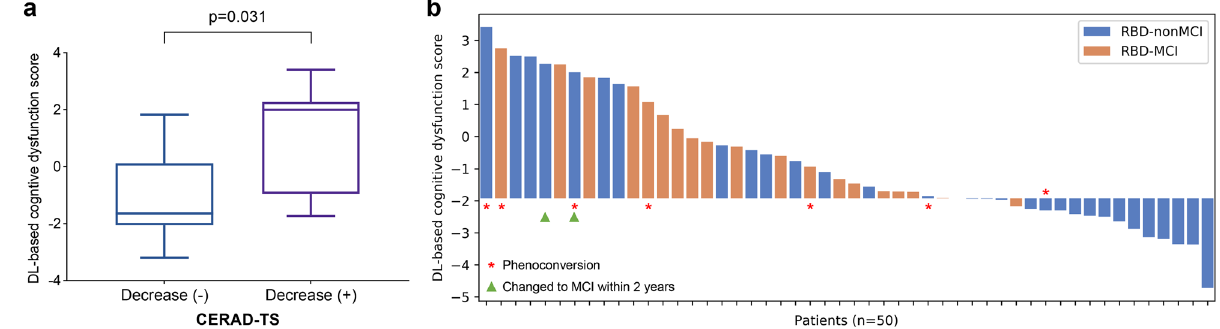
Figure 2. Association of longitudinal cognitive change in iRBD with DL-based cognitive dysfunction score. ( a ) DL-based cognitive dysfunction scores were higher in iRBD patients who showed a decrease in CERAD-TS on a 2-year follow-up than in those who did not. ( b ) DL-based cognitive dysfunction scores of RBD-MCI and RBD- nonMCI at baseline are visualized in the waterfall plot. The bars with asterisks or triangles indicate patients converted to overt neurodegenerative disease or MCI within 2 years. RBD-nonMCI RBD-MCI Non-converter Converter Non-converter Converter DL-based cognitive dysfunction score Above cutoff Below Table 2. Classification of iRBD patients with phenoconversion to overt neurodegenerative disease depending on the baseline diagnosis of MCI and optimal cutoff of DL-based cognitive dysfunction score based on [ 18 F] FDG PET. RBD rapid eye movement sleep behavior disorder, MCI mild cognitive impairment, RBD-MCI iRBD with MCI, RBD-nonMCI iRBD without MCI. a 2 PD and 1 MSA-C. b 2 PD and 1 DLB. c 1 PD.